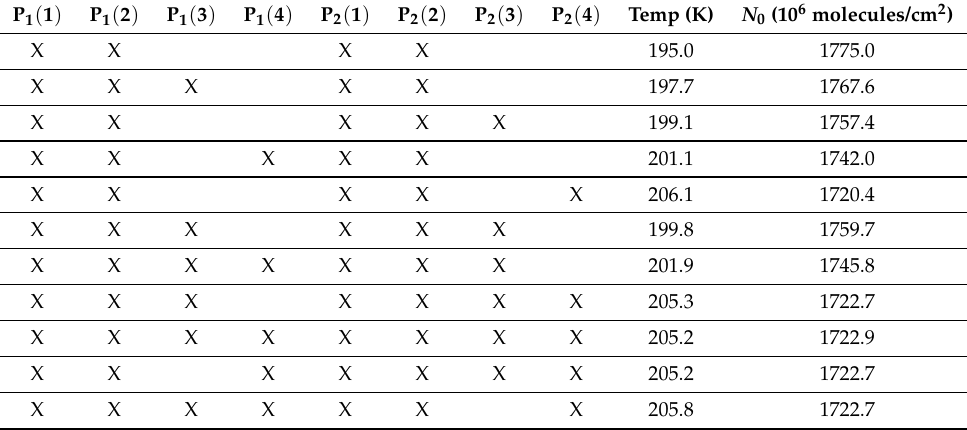
Table 1. Table of mean APOGEE OH ( 4 − 2 ) rotational temperatures and column densities as a function of emission line selection. The Einstein A coefficients of Mies were used for all calculations. The top row of the table lists the emission lines considered with the last two columns representing the resultant measured mean temperature and column density. Emission lines marked with an ‘X’ were used in that combination.